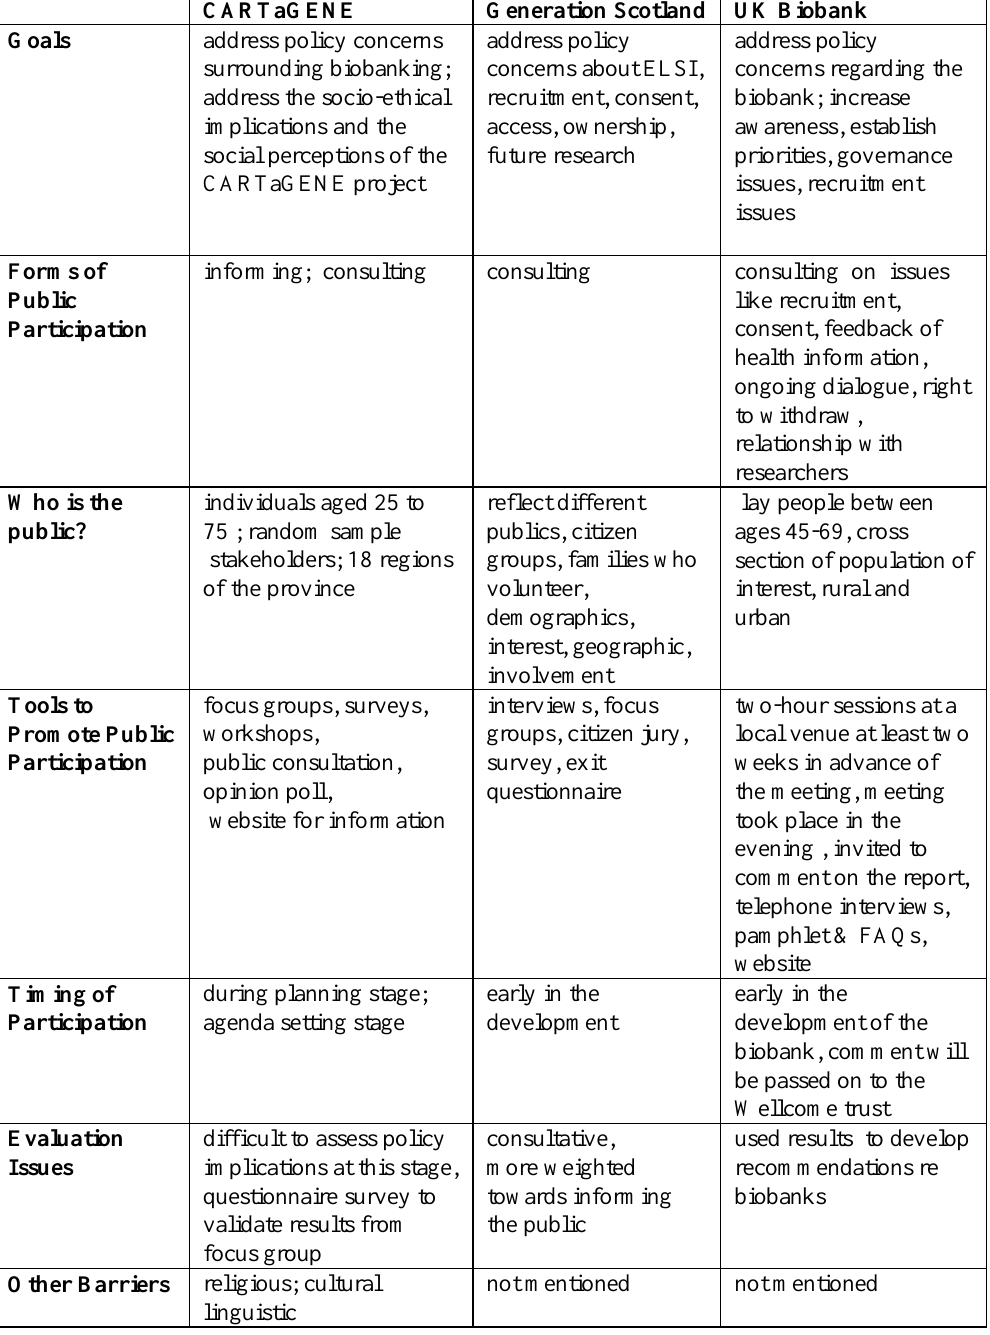
Table 1: Comparing Public Participation: CARTaGENE, Generation Scotland and UK Biobank